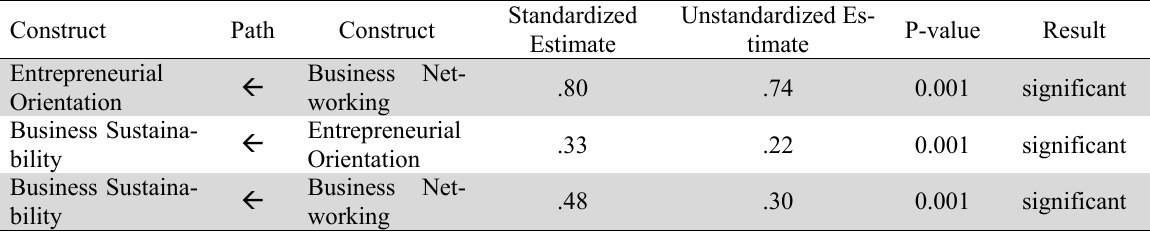
The results of hypotheses testing for the study Construct Path Construct